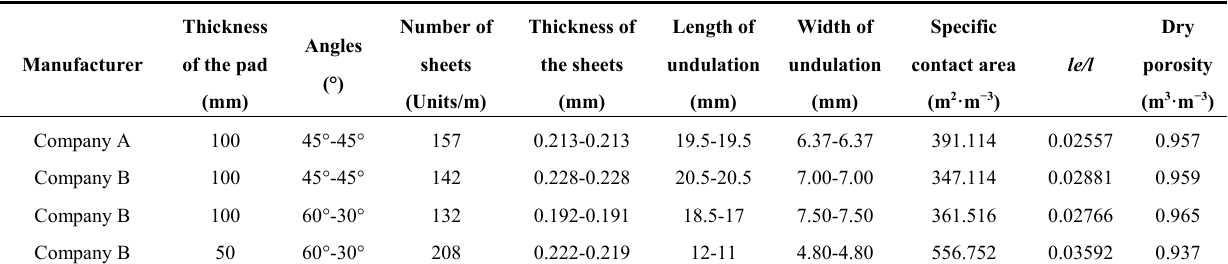
Table 2. Summary of the geometric characteristics of the cellulose